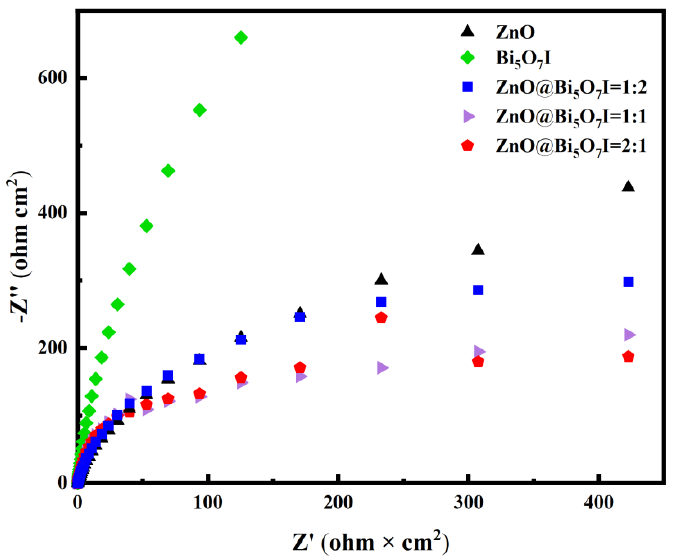
Figure 10. The Nyquist curves of the electrochemical impedance spectra displayed by the ZnO, Bi 5 O 7 I, and ZnO@Bi 5 O 7 I heterogeneous connections. Mott-Schottky (MS) plots of ZnO, Bi 5 O 7 I, and ZnO@Bi 5 O 7 I were evaluated, as shown